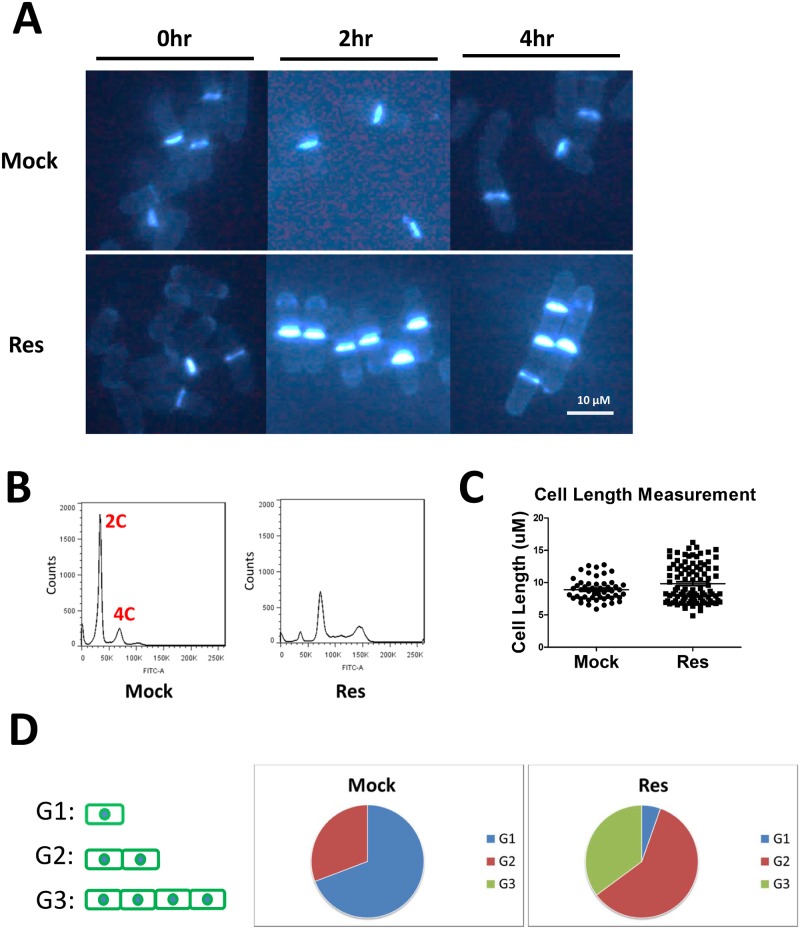
Resveratrol can inhibit cell proliferation by inhibiting sister cell’s separation.(A) Calcofluor staining to visualize the cell septum: 120 μg/ml resveratrol and mock reagent (ethanol) were used to treat the yeast cells for 0, 2 and 4 hrs (B) FACS analysis: 120 μg/ml resveratrol was used to treat the yeast cell for 0 and 4 hrs. (C) The single cell size measurement: 120 μg/ml resveratrol was used to treat the yeast cell for 6 hrs, over 50 cells were counted respectively. (D) The unsplitted septum counting: 120 μg/ml resveratrol was used to treat the yeast cell for 6 hrs, G1,G2 and G3 represent the cell chain with 0, 1 and 2 septum respectively, over 30 cells were counted.